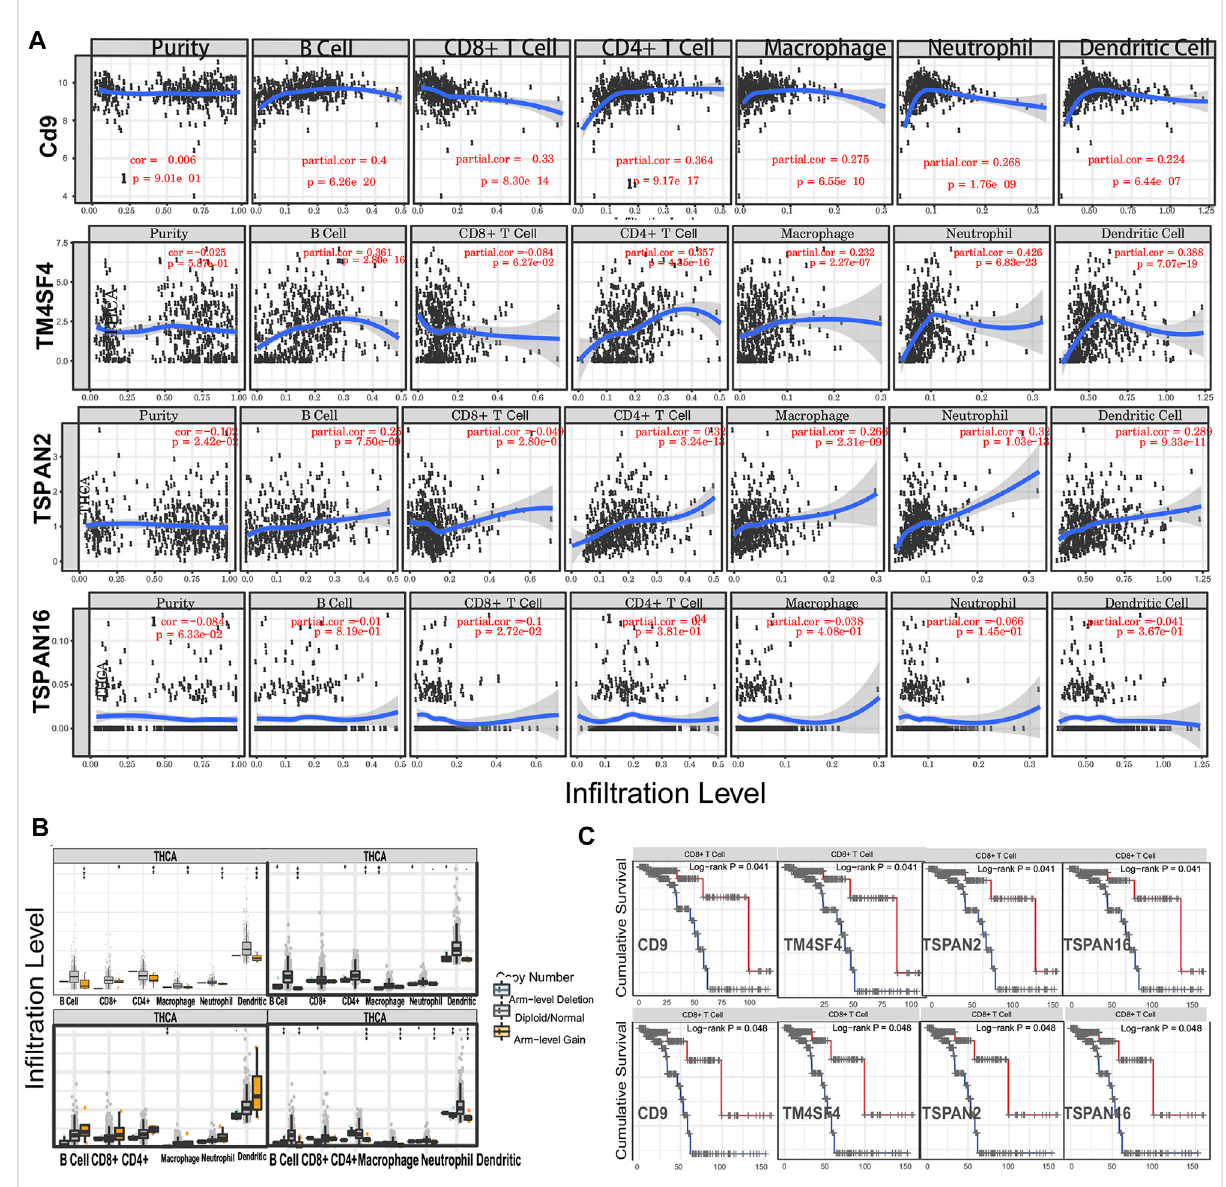
FIGURE 8 TM4SFs affect the prognosis and survival of PTC patients via immune in fi ltration. (A) The correlation of TM4SF members and tumor in fi ltrating immune cells via Tumor Immune Estimation Resource (TIMER); (B) The comparison of tumor in fi ltration levels of PTC with different somatic copy number alterations (SCNAs) for TM4SF members (deep deletion ( − 2), arm-level deletion ( − 1), diploid/normal (0), arm-level gain (1), and high ampli fi cation). (C) The 10-year and 15-year immune cell in fi ltration survival curve of TM4SFs in PTC patients